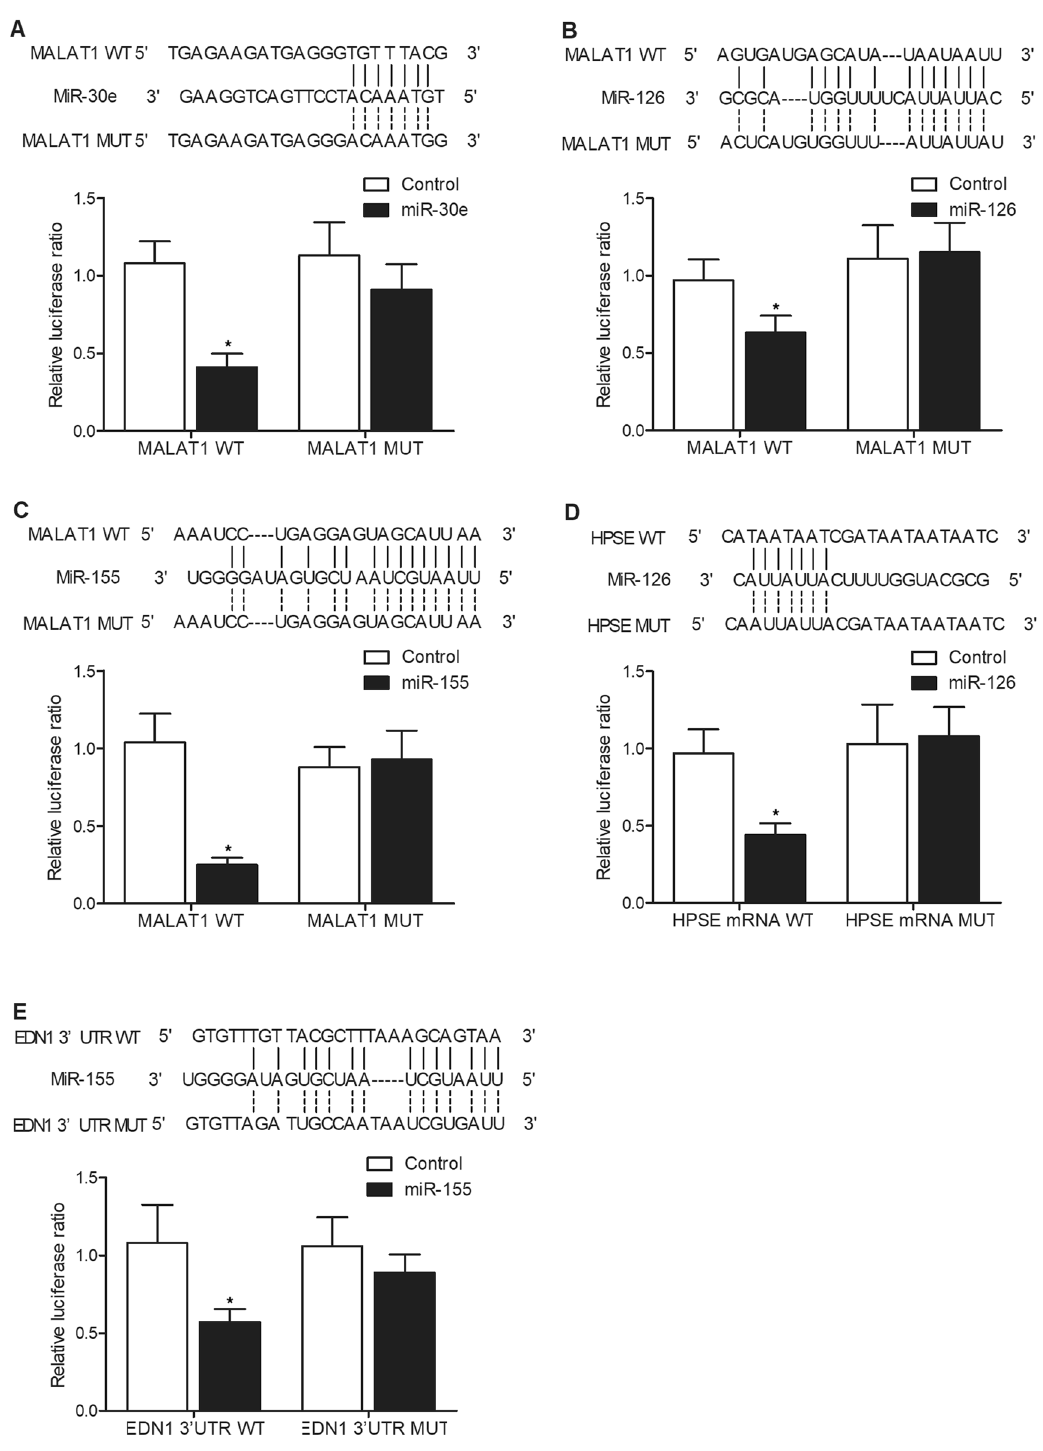
Figure 3. Luciferase assays were used to explore the relationship of MALAT1/miR-30e, MALAT1/miR-126, MALAT1/miR-155, miR-126/HPSE, and miR-155/EDN1 (* P value < 0.05 vs. Control group). ( A ) The luciferase activity of MALAT1 was suppressed by miR-30e in HUVEC and HAEC cells. ( B ) The luciferase activity of MALAT1 was suppressed by miR-126 in HUVEC and HAEC cells. ( C ) The luciferase activity of MALAT1 was suppressed by miR-155 in HUVEC and HAEC cells. ( D ) The luciferase activity of HPSE was suppressed by miR- 126 in HUVEC and HAEC cells. ( E ) The luciferase activity of EDN1 was suppressed by miR-155 in HUVEC and HAEC